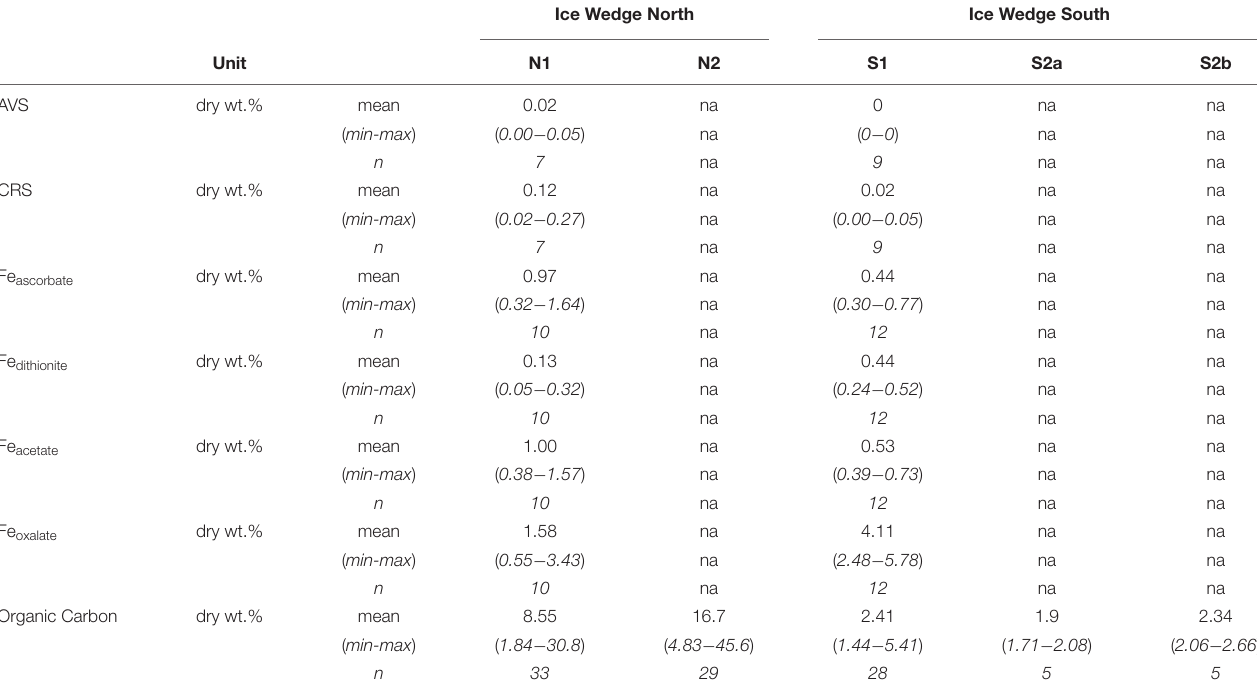
Organic Carbon dry wt.%